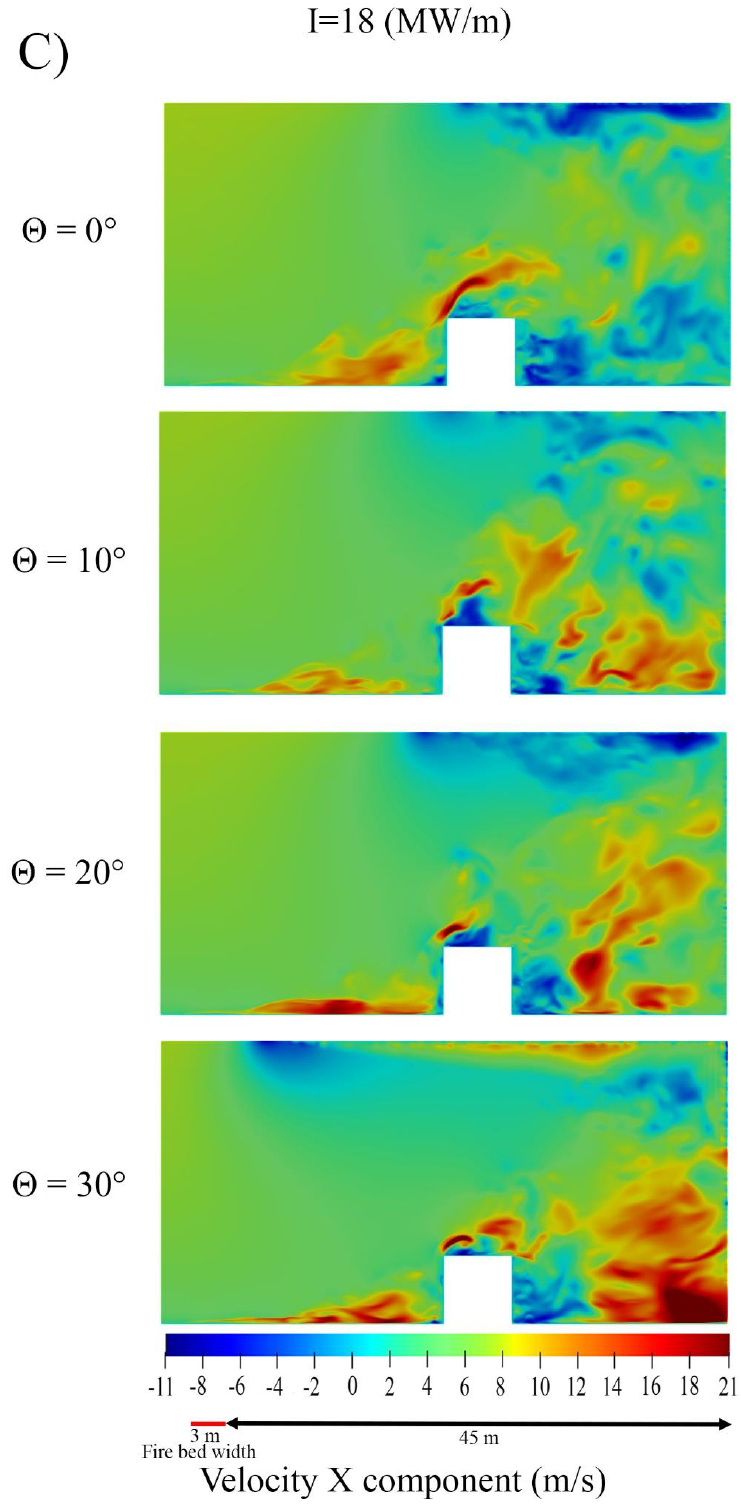
Figure 3. Vertical transects of the stabilized state streamwise velocity component (Ux) for the reference velocity U ref = 6 m/s in various fire intensities and slopped terrains ( A ) Fire intensity of 10 (I = 10 MW/m), ( B ) Fire intensity of 14 (I = 14 MW/m) and ( C ) Fire intensity of 18 (I = 18